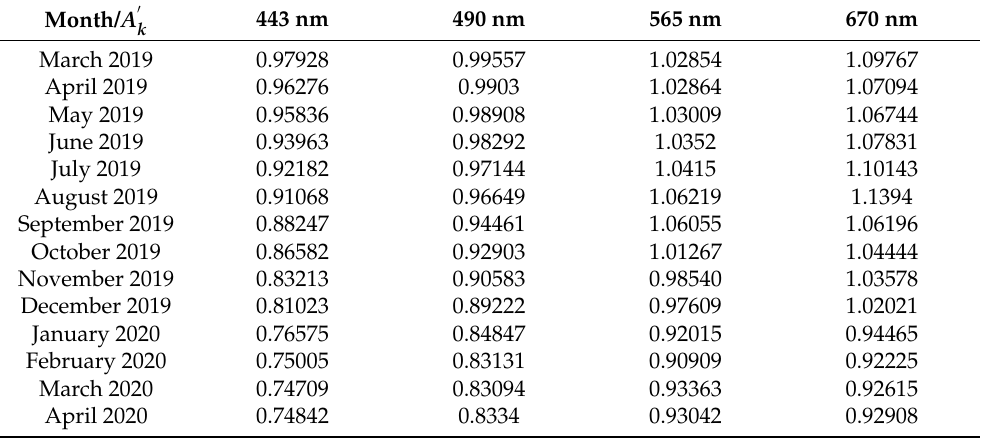
Table 3. Monthly absolute calibration coefficient A (cid:48) visible bands of